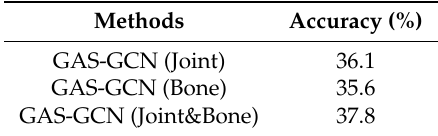
Table 5. Two-stream fusion results of Top-1 accuracy on Kinetics dataset.